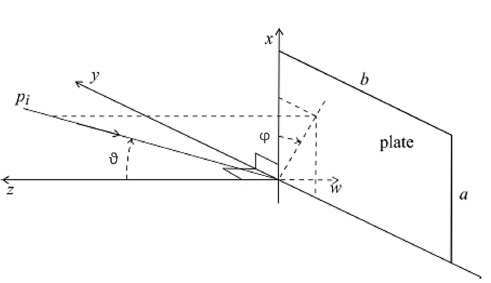
Figure 7. Schematic of a plane wave incident on a rectangular